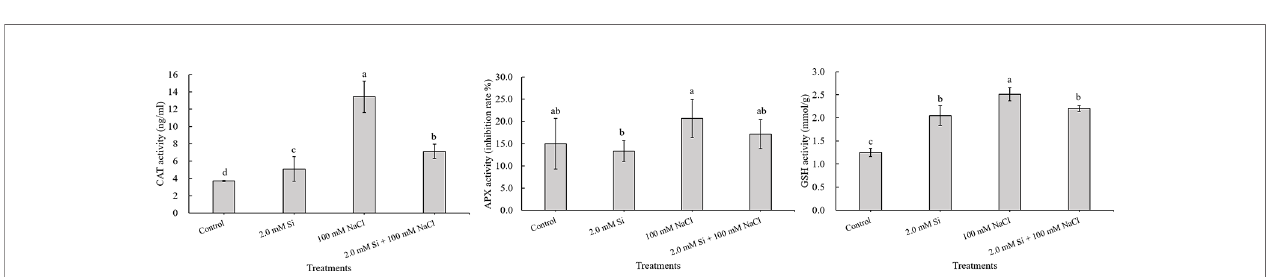
FIGURE 4 | Changes in antioxidant activity after single or combined Si and NaCl. Data were collected after salt stress for 24 h. Different letters above error bars indicate signi fi cant differences by Duncan's multiple range test ( P < 0.05). Data were collected in triplicate and are presented as the average ± standard error ( n =